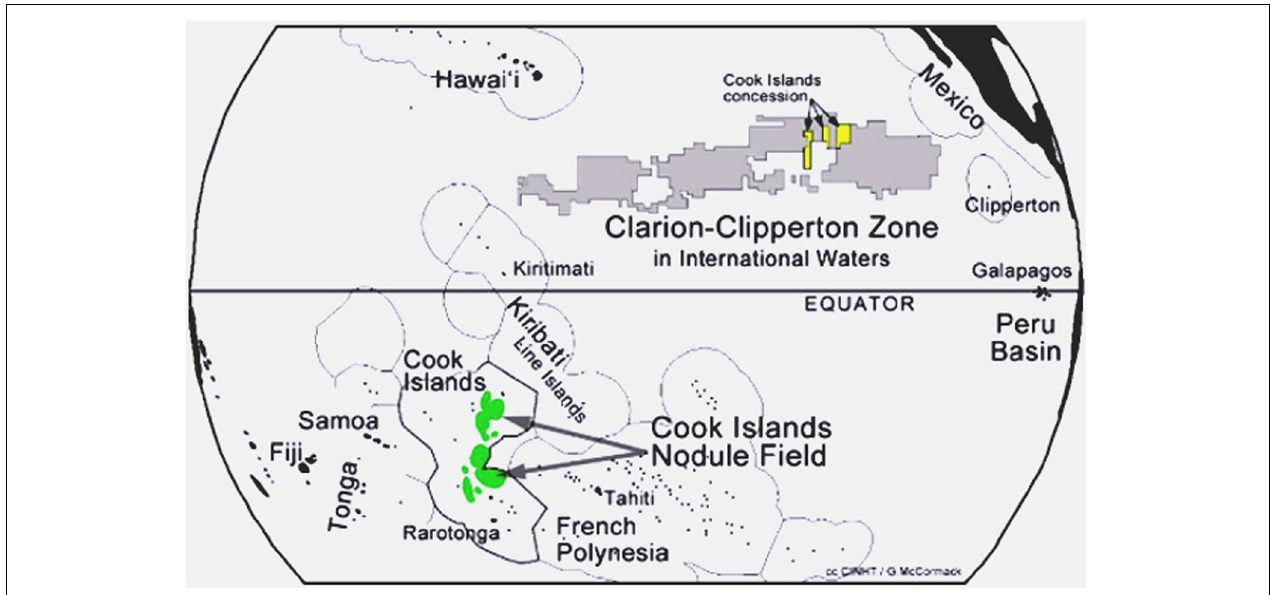
FIGURE 4 | Context map showing the Cook Islands manganese nodule fields in relation to neighbouring countries and the Clarion Clipperton Zone [Figure constructed by McCormack (2016) and Petterson and Tawake (2016)].